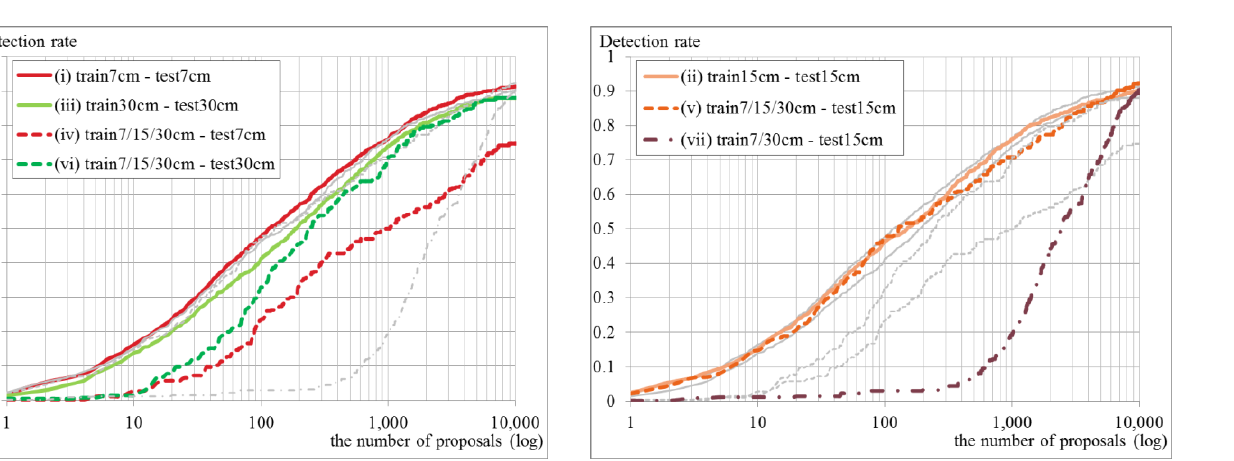
Figure 11. Comparison of detection rate between combinations of multiple spatial resolutions (ii, v and vii)